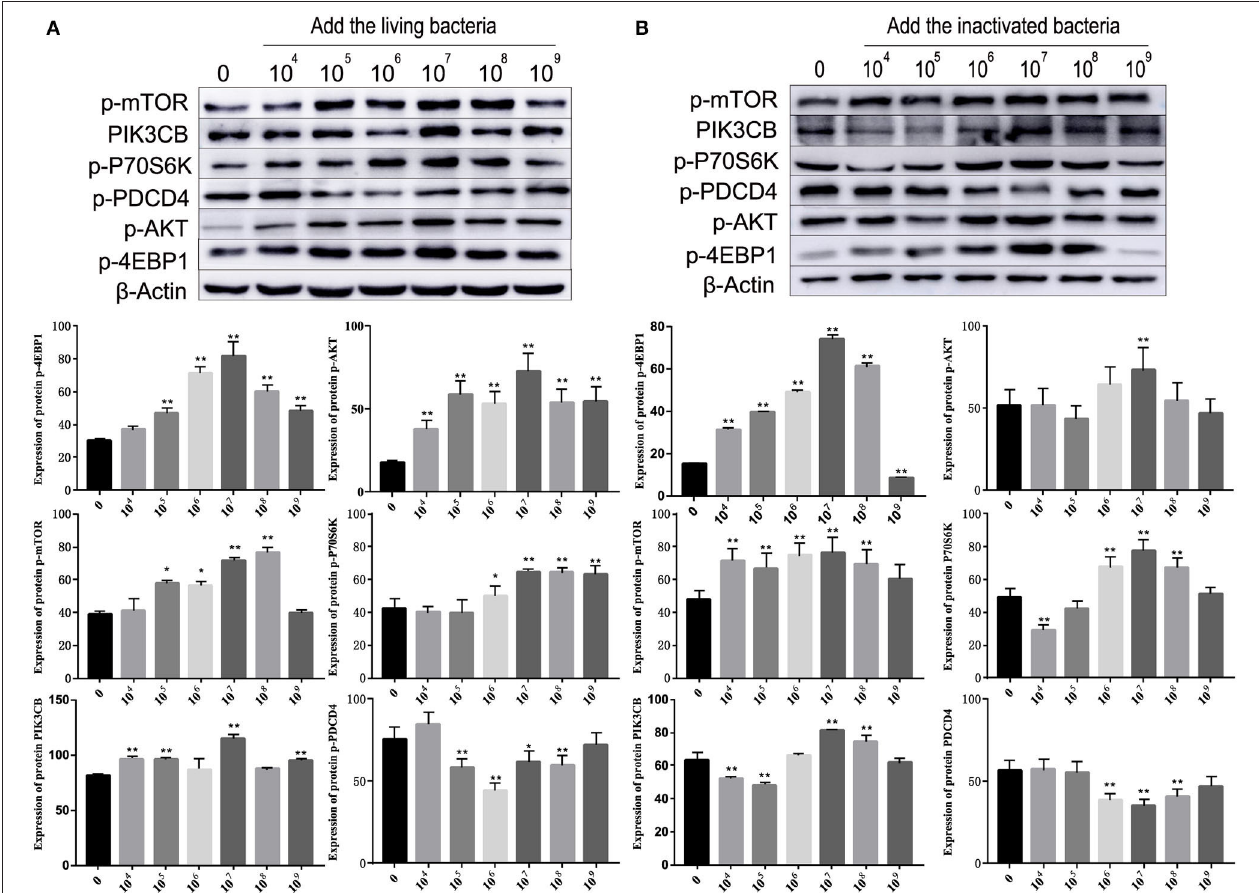
FIGURE 7 | Effects of different concentrations of living bacteria Bacillus subtilis IIIVE-4 (A) and inactivated bacteria Bacillus subtilis IIIVE-4 (B) on protein expressions in the PIK3CB-AKT-mTORC1 pathway in rumen explants ( n = 9). The protective mechanism of 2.0 × 10 7 cfu/ml B. subtilis can promote protein synthesis in rumen explants by the PIK3CB-AKT-mTORC1 pathway. In the rumen of Holstein cows, 2.0 × 10 7 cfu/ml B. subtilis IIIVE-4 was able to secrete nutrients (methionine, leucine, etc.) to enhance protein synthesis by acting on the PIK3CB-AKT-mTORC1 signaling pathway and increasing the expression levels of 4EBP1 and P70S6K proteins. The expression of PIK3CB, p70s6k, AKT, and 4EBP1 proteins was highest when adding live IIIVE-4 bacteria at a concentration gradient of 10 7 cfu/ml, while mTOR proteins reached their highest expression at 10 8 cfu/ml and PDCD4 at 10 6 cfu/ml, but P70S6k and 4EBP1, which are more closely related to protein synthesis, reached their highest at a concentration gradient of 2.0 × 10 7 cfu/ml, so 2.0 × 10 7 cfu/ml was determined as the optimal bacterial solution concentration. One-way ANOVA in SPSS 22.0 software was used to analyze the data, presented as mean ± sd. The ratio of all gene expression levels compared to the housekeeping gene β -actin was obtained as the relative expression of the gene. *Indicates significant difference from control group within the same group ( p < 0.05). **Indicates a highly significant difference ( p <